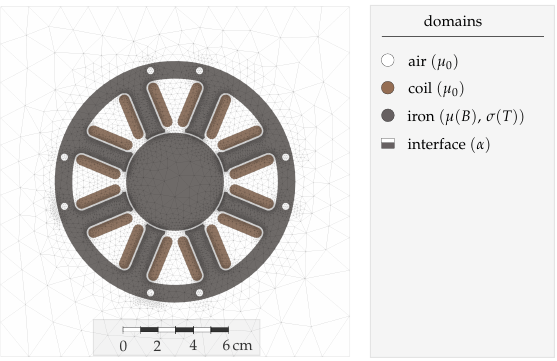
Figure6. 2D-modelofanactivemagneticbearingwithfiniteelementmesh Figure 6. Two-dimensional model of an active magnetic bearing with finite element